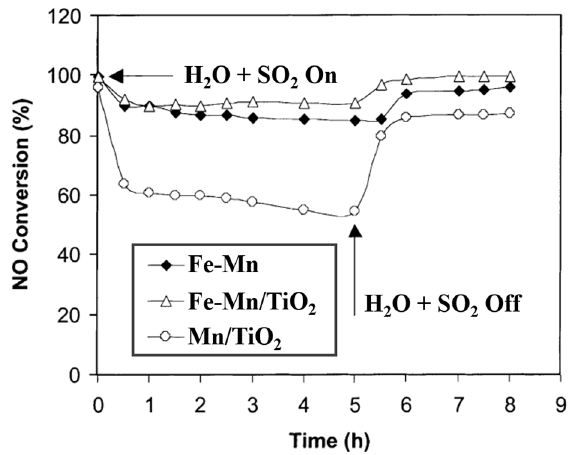
Figure 18. NO conversion on the various Fe–Mn-based catalyst in the presence of SO 2 + H 2 O (Reaction conditions: temperature = 150 °C, [NO] = [NH 3 ] = 1000 ppm, [O 2 ] = 2%, [SO 2 ] = 100 ppm, [H 2 O] = 2.5%, balance He, total flow rate 100 mL/min, catalyst 0.5 g). (Reproduced with permission from Reference [41], Copyright 2003, Elsevier.).